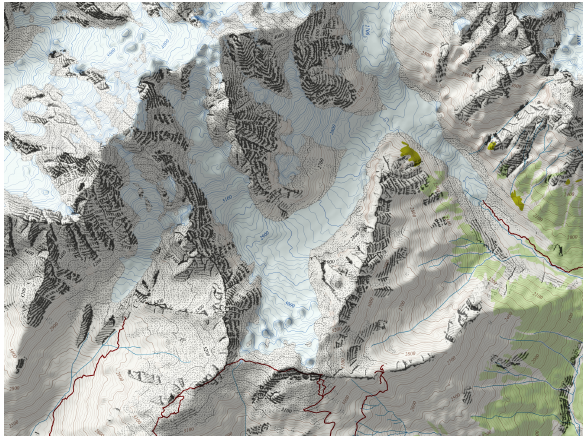
Figure 6. Relief depiction preview around Mt. Ushba from Jaspersen (2021) as generated from the customized DEM, rock and ice masks from Schr¨oder (2020), and tracks and forest mask from OpenStreetMap. Scale